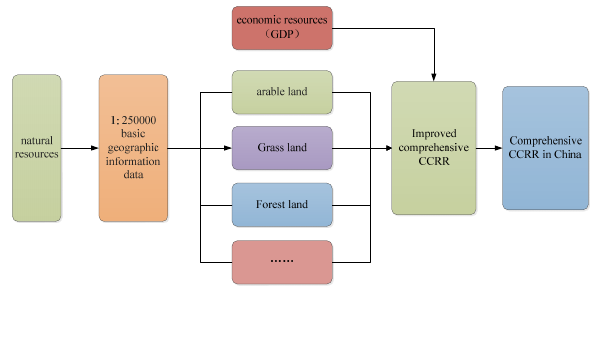
Figure 2. An improved model of